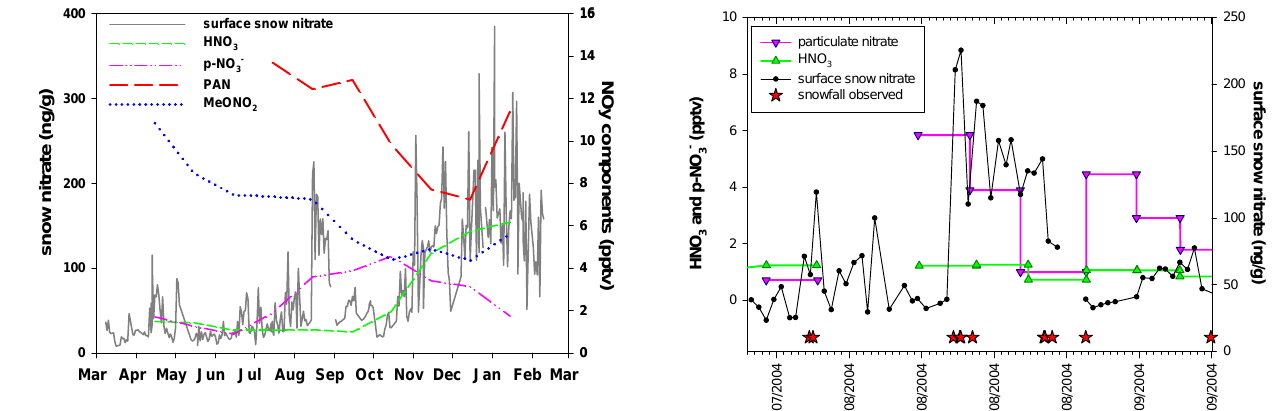
Fig. 4. Daily surface snow nitrate plotted against certain NO y com- ponents.